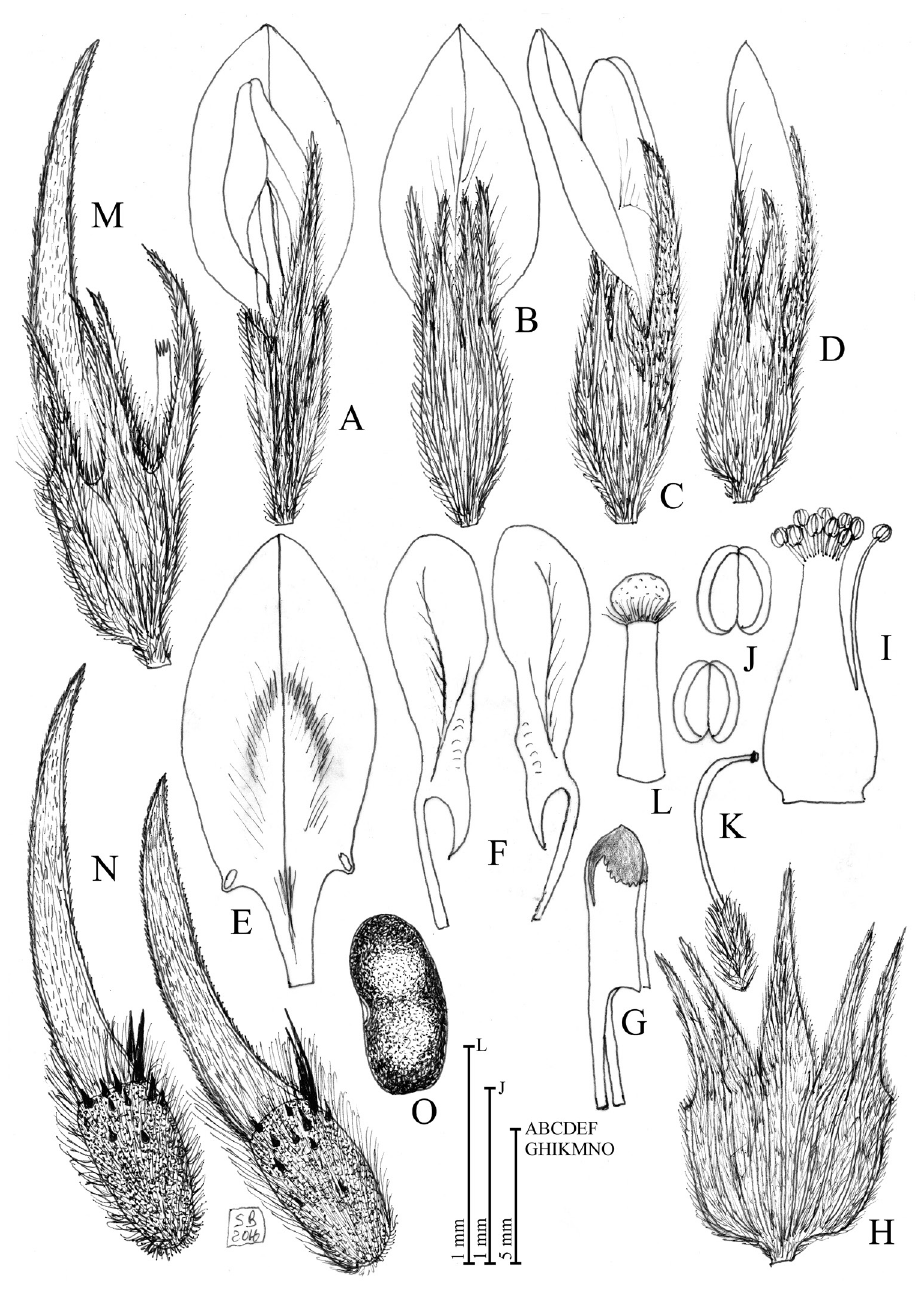
Figure 1. Diagnostic features regarding the reproductive structures of Bituminaria antiatlantica. A Flow- er (ventral view) B Flower (dorsal view) C Flower (lateral view) D Bud E Standard F Wings G Keel (lateral view) H Calyx (open) I Staminal tube J Anthers K Pisti L Stigma M Fruiting calyx and pod N Pods O Seed. Illustration by S. Brullo based on living material coming from Mount Tachilla and Djebel Imzi in Morocco